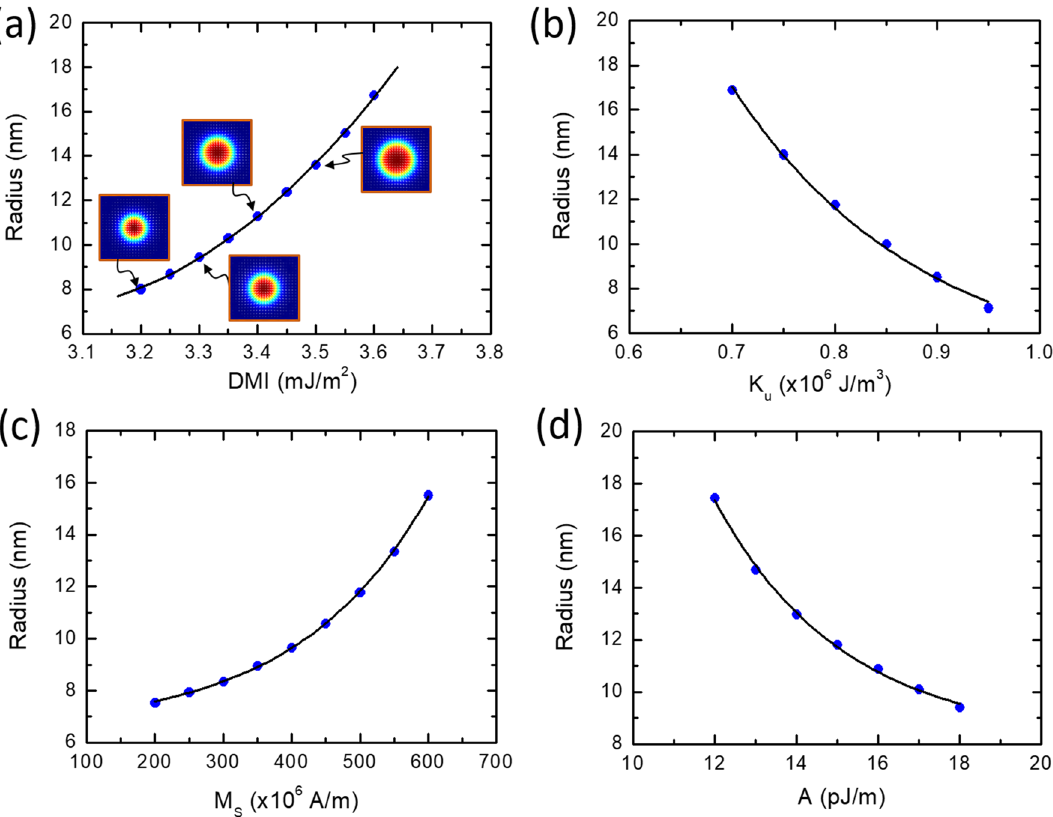
Figure 8. The dependence of the skyrmion radius on ( a ) DMI, ( b ) magnetic uniaxial anisotropy energy, ( c ) saturation magnetization and ( d ) exchange stiffness. Case ( a ) reveals a second-order polynomial growth function, ( b ) and ( d ) show an exponential decay of the radius with K u and A while for ( c ) the radius grows exponentially with M s